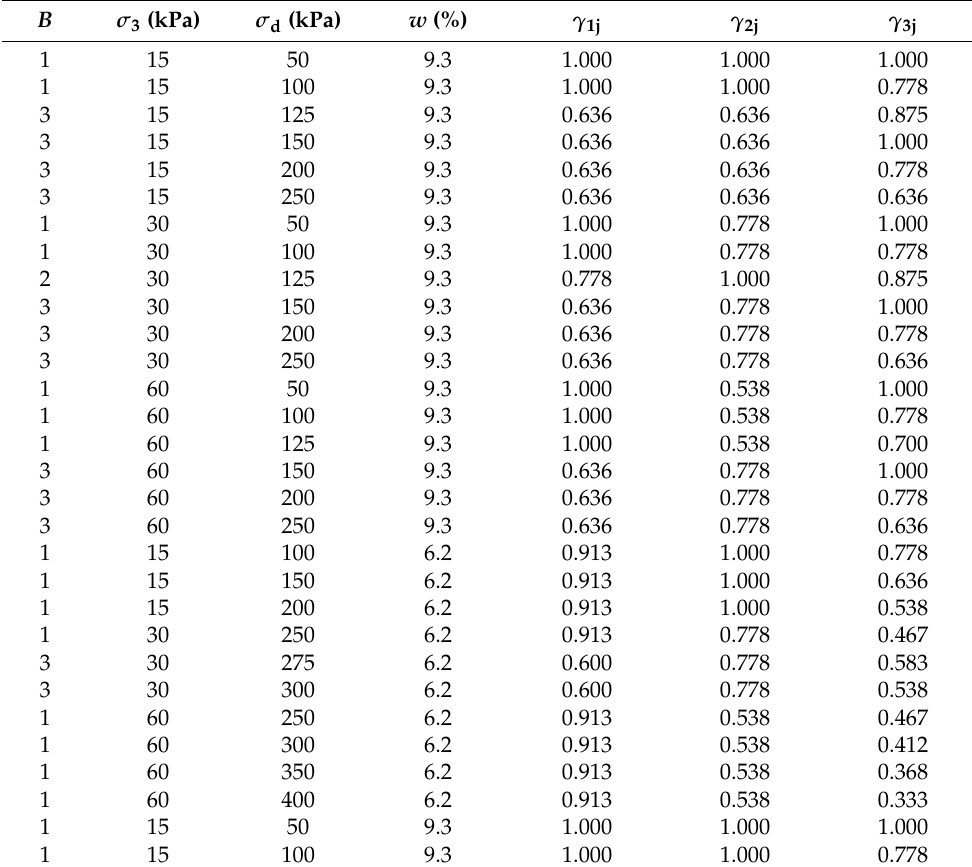
Table 2. Grey relational coefficients of β with respect to w , σ 3 , and σ d